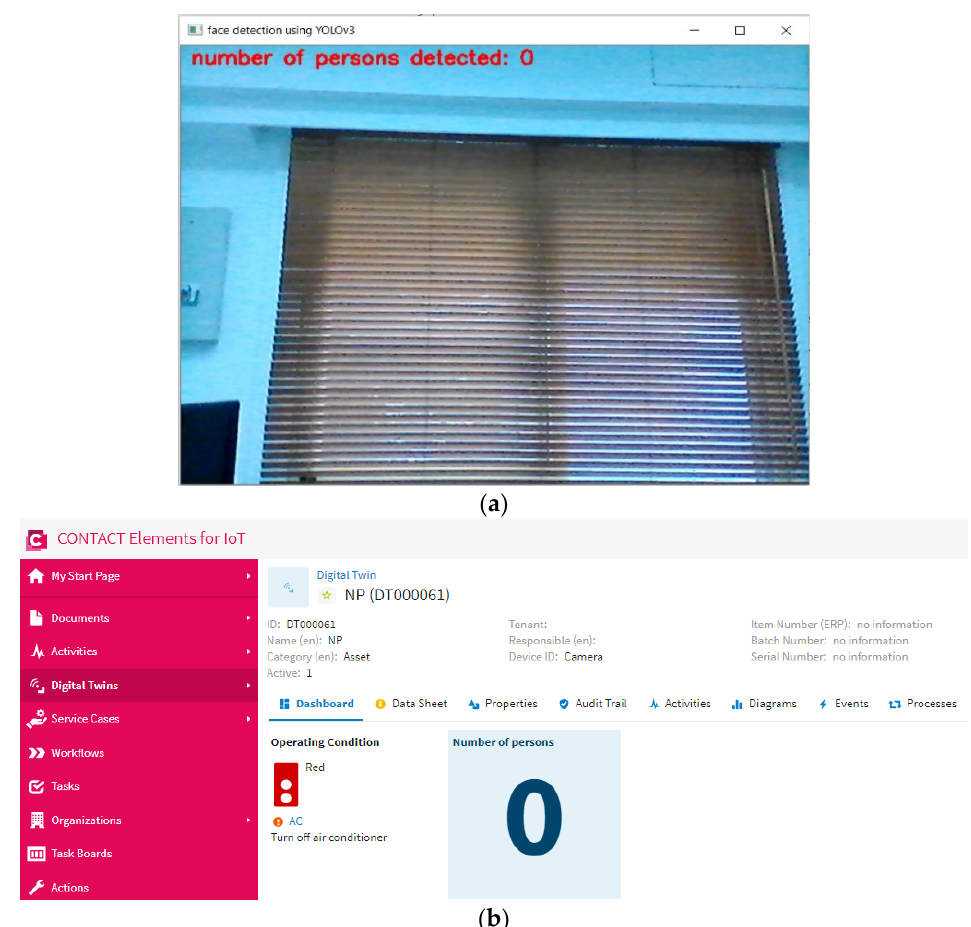
Figure 14. Air conditioner status in the case of an increasing number of persons being present in the specified area.